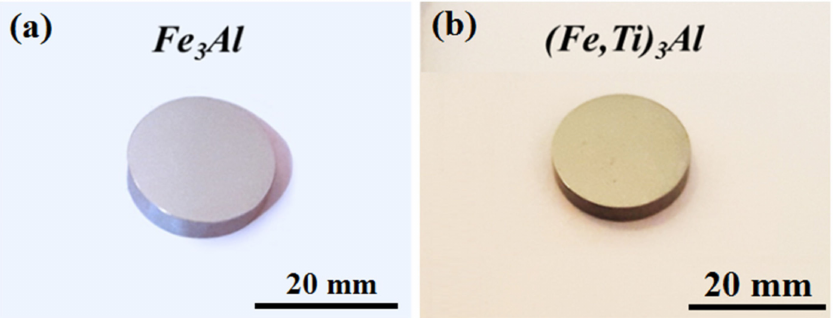
Figure 1. The prepared nanostructure ( a ) Fe 3 Al and ( b ) (Fe,Ti) 3 Al compounds produced by the SPS